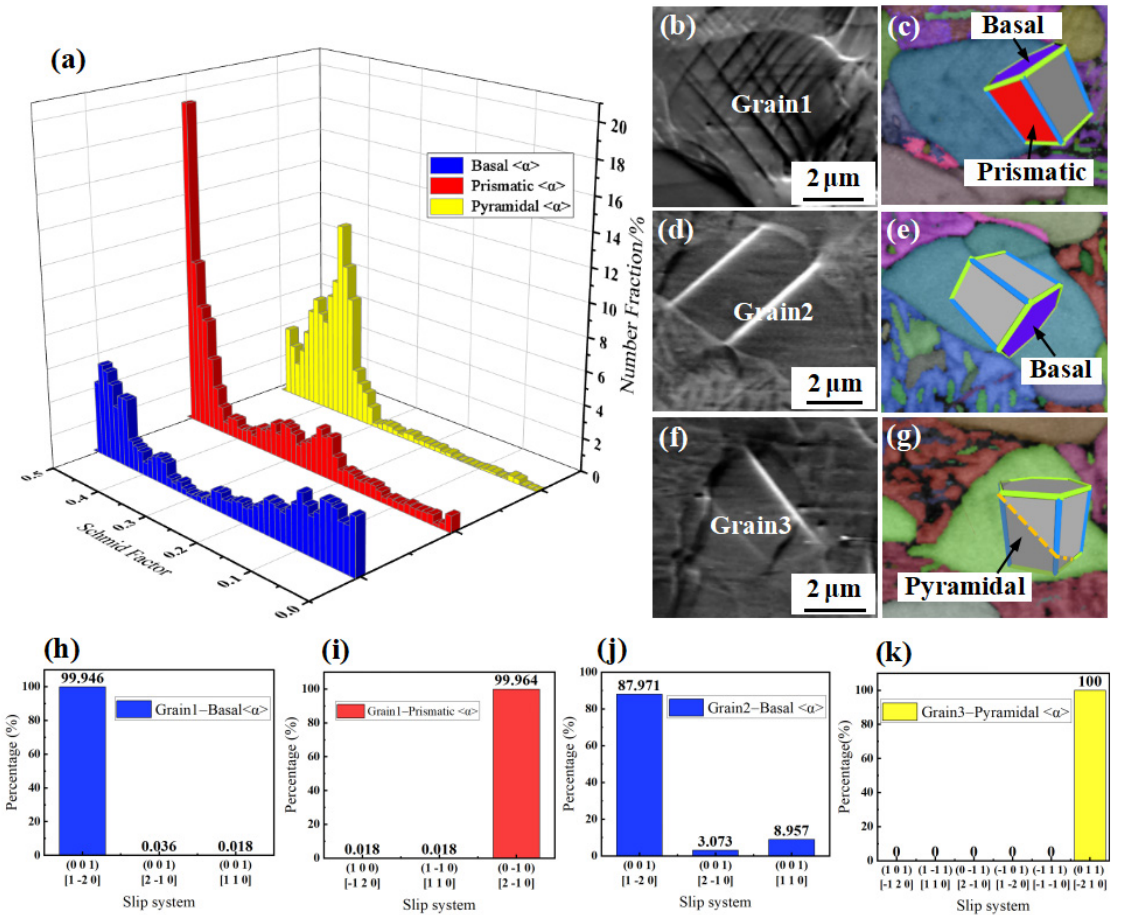
Figure 11. ( a ) SF histogram of α phase with basal < α >, prismatic < α >, and pyramidal < α > slip systems for bimodal microstructure after stretching in situ; ( b , c ) Multislip activation of Grain 1 in the α P phase; ( d , e ) Basal slip activation of grain 2 in the α P phase; ( f , g ) Pyramidal slip activation of Grain 3 in the α P phase; ( h ) The (001)[1 2 0] basal slip system activation for Grain 1; ( i ) The (0 1 0)[2 1 0] prismatic slip system activation for Grain 1; ( j ) The (001)[1 2 0] basal slip system activation for Grain 2; ( k ) The (011)[ 2 10] slip system activation for Grain 3.